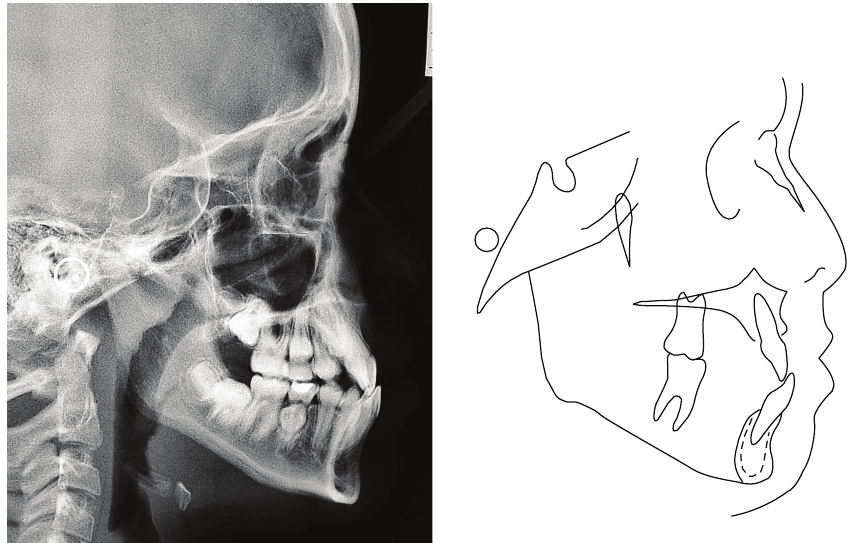
Figure 2: Lateral cephalogram radiograph.